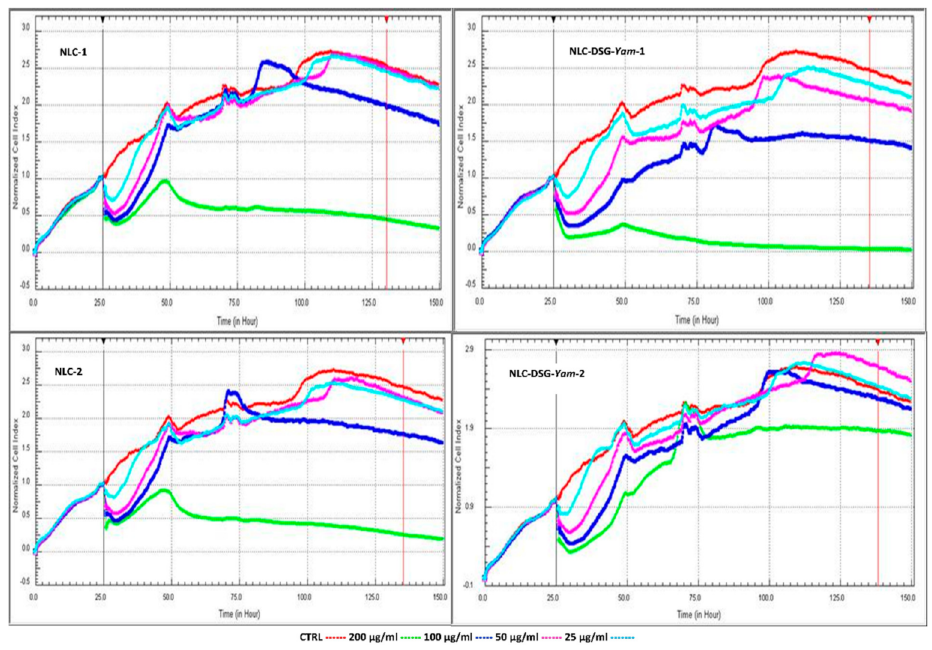
Figure 7. Cytotoxic vs. proliferation induced by NLC-DSG-Yam as compared with free